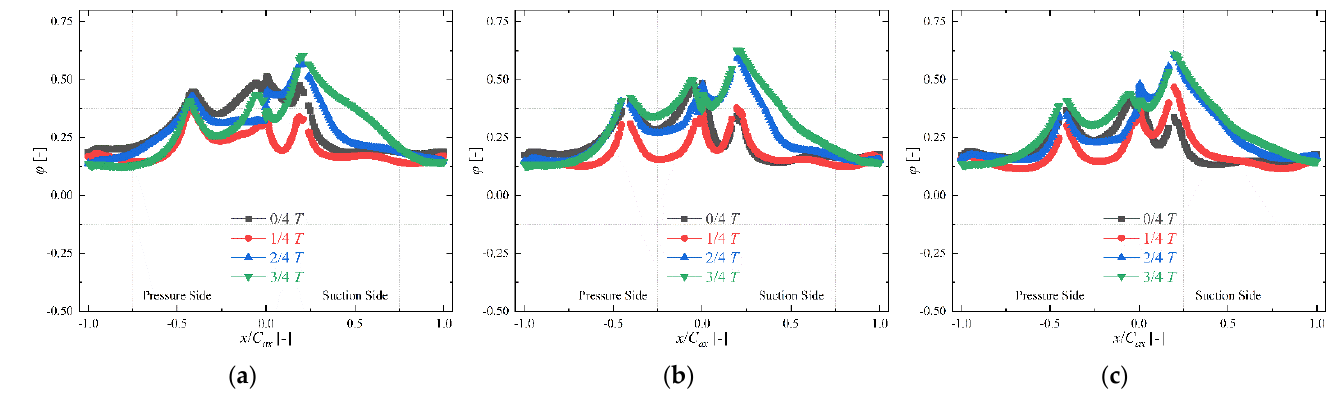
Figure 12. The overall cooling effectiveness distribution along the blade surface. ( a ) At 25% span; ( b ) at 50% span; ( c ) at 75% span. ( b ) at 50% span; ( c ) at 75%